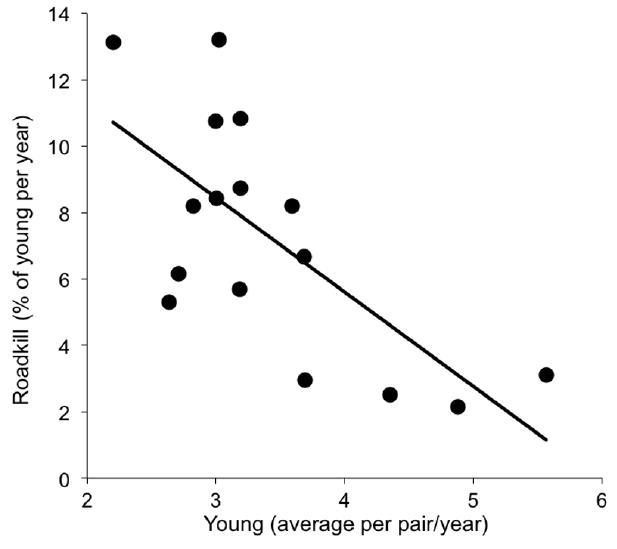
Fig. 9 . Relationship between nest success (expressed as the average number of young per pair per year) and the number of roadkill (expressed as the total yearly death toll as a fraction of the total number of young that is produced). In years of high nest success, traffic mortality is less intense (Pearson correlation test; N = 16 [1994–2009], r² = 0.48, ts = 3.59, p <